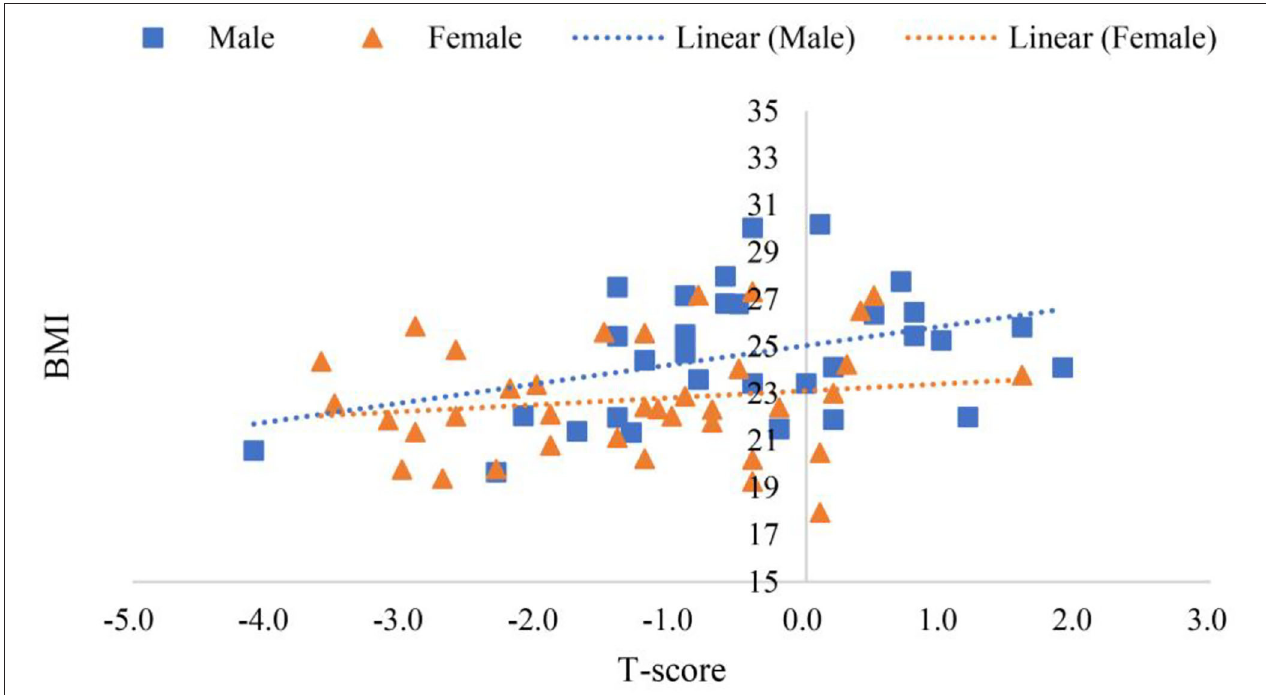
FIGURE 7 | Scatter plots of participants’ BMI and T -score.